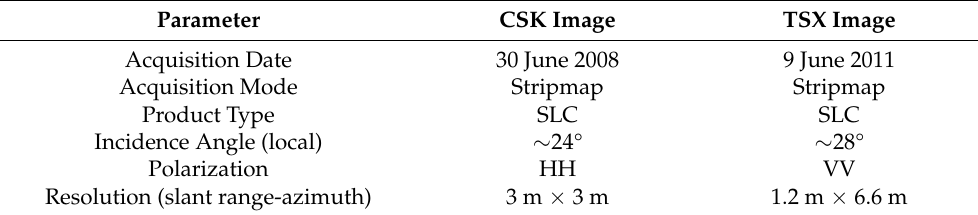
Table 5. Main characteristics of TerraSAR-X (TSX) and Cosmo-Skymed (CSK) X-band products. Parameter